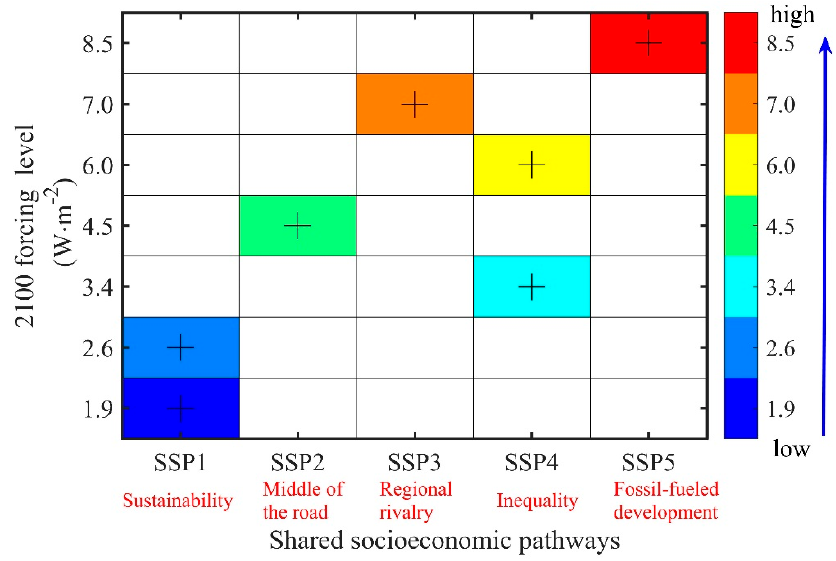
Figure 2. SSP-RCP scenarios matrix illustrating ScenarioMIP simulations (indicated by di ff erent colors). Each cell in the matrix indicates a combination of Shared Socioeconomic Pathways (SSPs) and the Representative Concentration Pathways (RCPs). The vertical represents the future level of radiation forcing, and the forcing level usually refers to the forcing reaching in 2100. The seven values of rows represent radiation levels achieved 1.9, 2.6, 3.4, 4.5, 6.0, 7.0 and 8.5 W m − 2 respectively by the end of the 21st century, and they are represented by di ff erent colors (i.e., blue is 1.9 W m − 2 , light blue is 2.6 W m − 2 , and bright red is 8.5 W m − 2 , and so on). Five columns represent five di ff erent SSPs and are marked red on the bottom of the panel. The colored cells represent seven SSP-RCP scenarios used in this study.